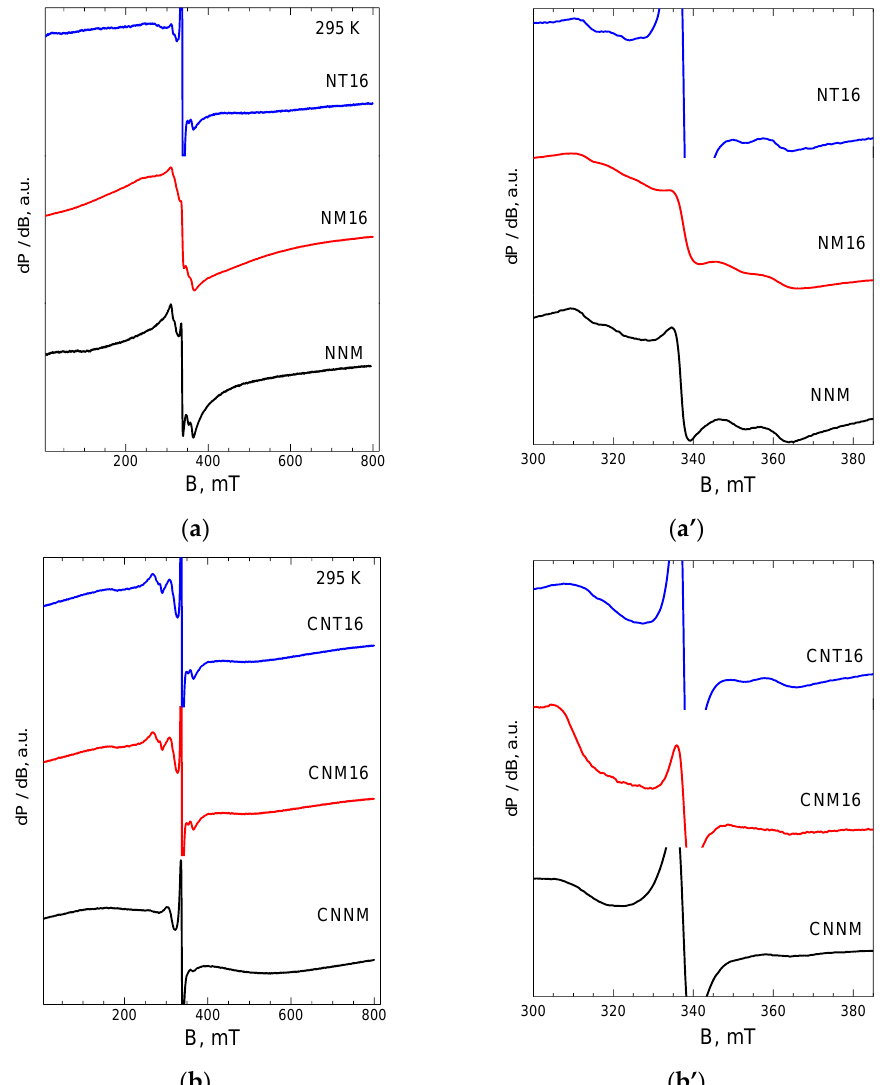
Figure 10. EPR spectra of metal-substituted oxides ( a,a’ ) and CeO 2 -treated oxides ( b,b’ ) after cycling in lithium-ion cells. The right figures present the EPR spectra in the narrow range of the magnetic field. The parts of the spectra in the narrow range of magnetic field (i.e., between 300 and 385 mT) are also shown ( a’ , b’ ).